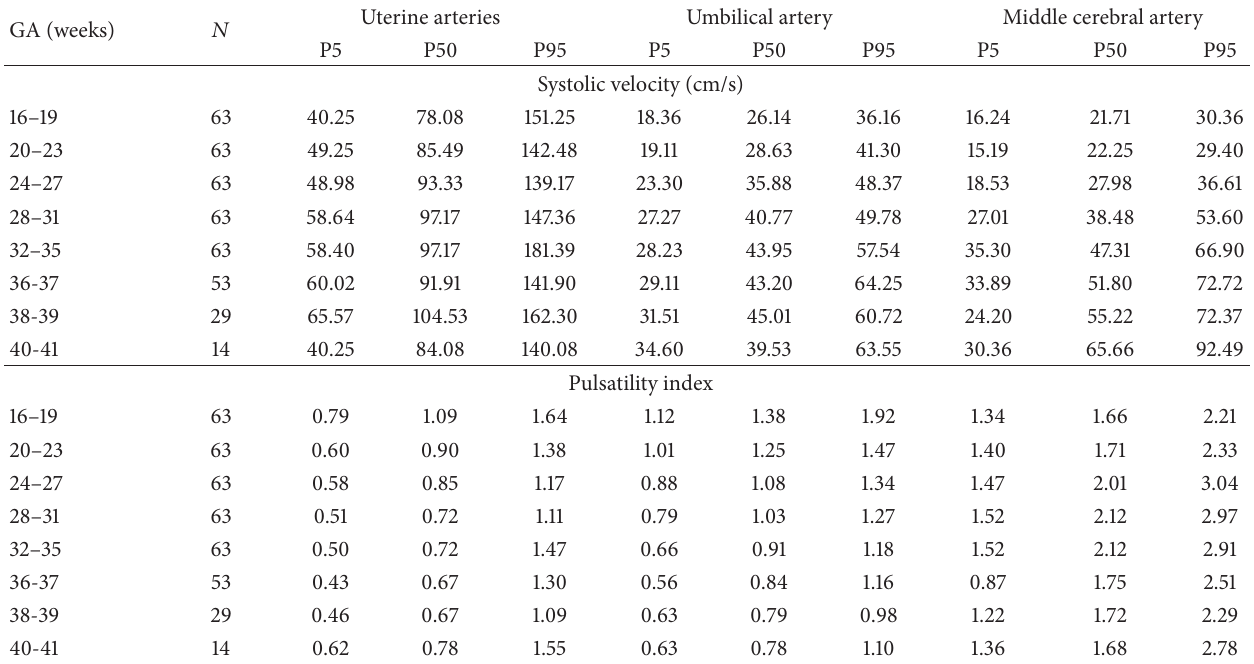
Table 3: Percentiles 5, 50, and 95 of SV and PI of uterine, umbilical, and middle cerebral arteries according to gestational age intervals. GA (weeks)